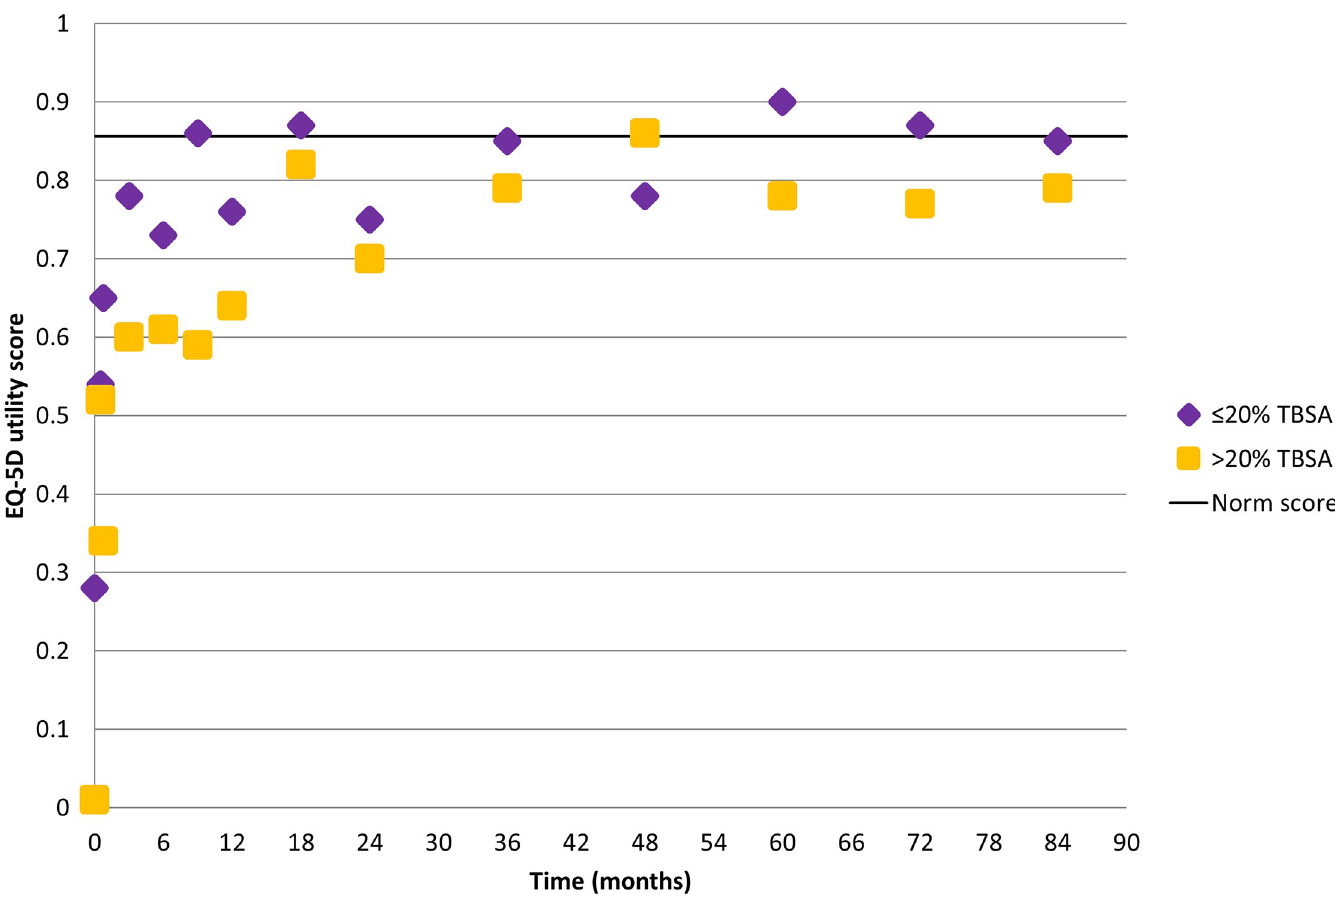
Fig 2. Combined EQ-5D utility scores for the subgroups of patients � 20%TBSA burned and > 20%TBSA burned compared with the norm score from the United Kingdom. The number of patients ranged between 13 and 680 for patients � 20%TBSA burned; and between 10 and 148 for patients > 20%TBSA